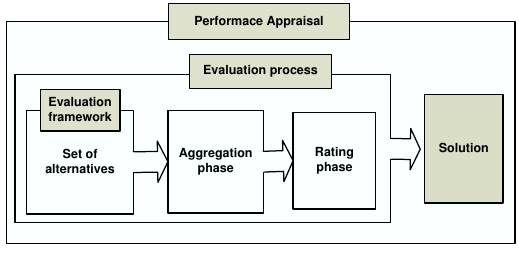
Fig. 4. Evaluation process